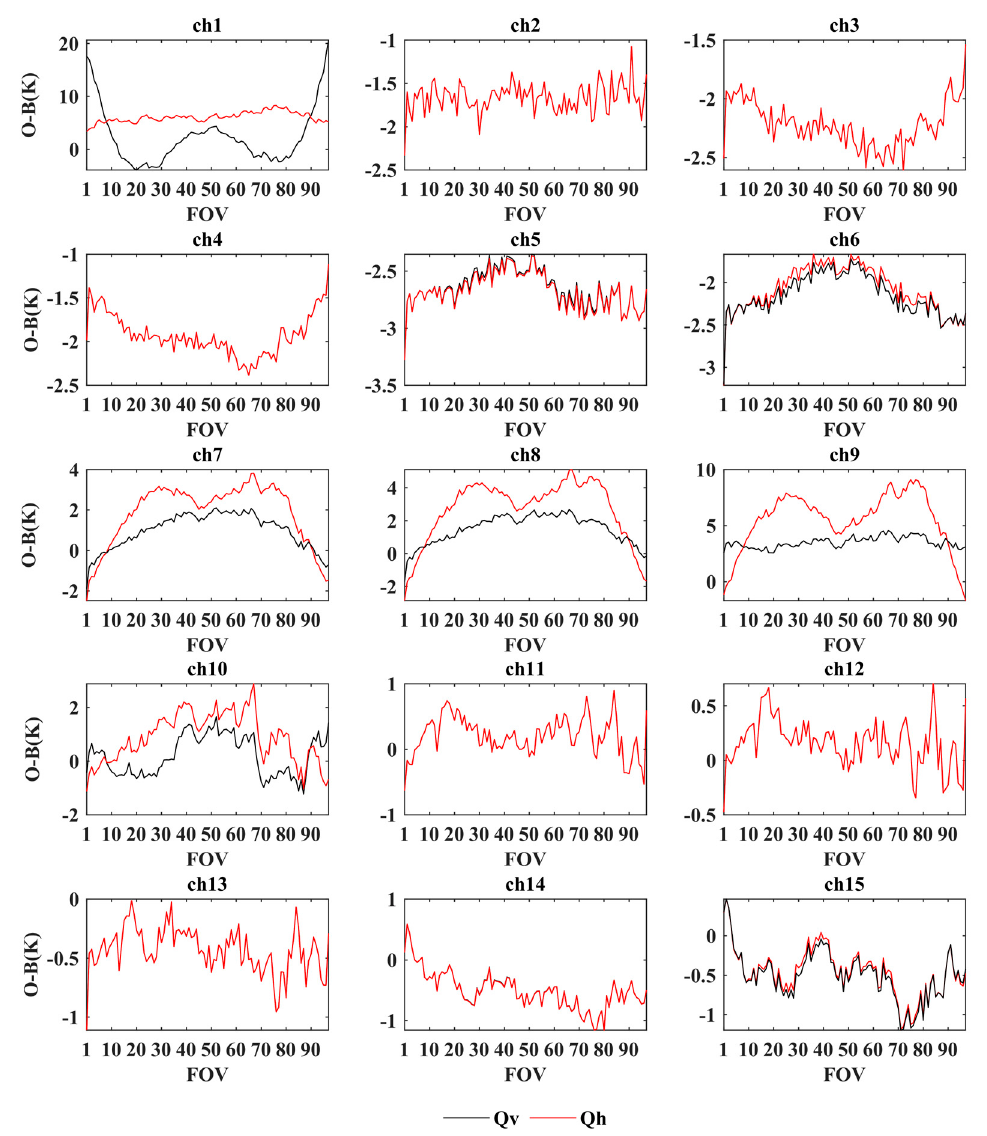
Figure 3. The same as Figure 1, but for FY-3E MWHS-II.